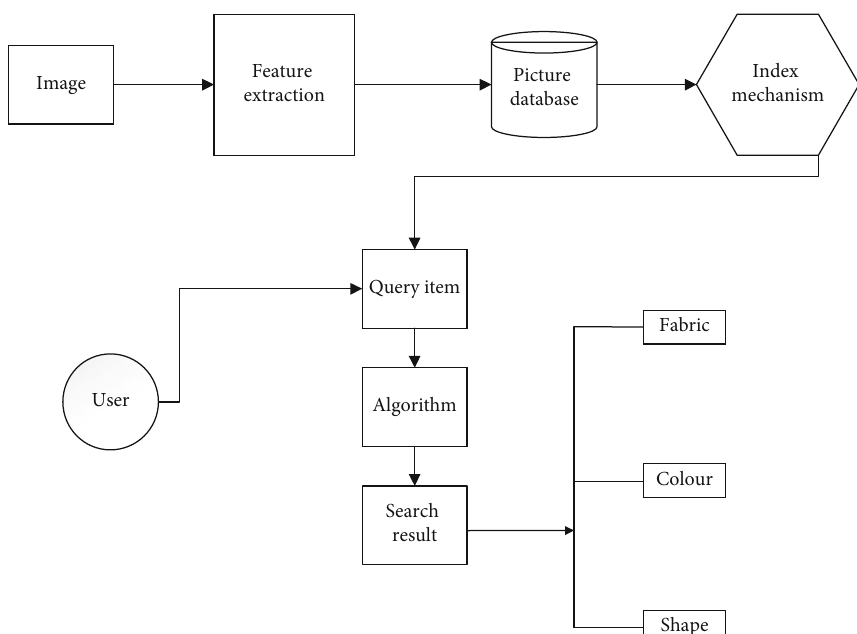
Figure 2: Neural network model for partial di ff erential equations.